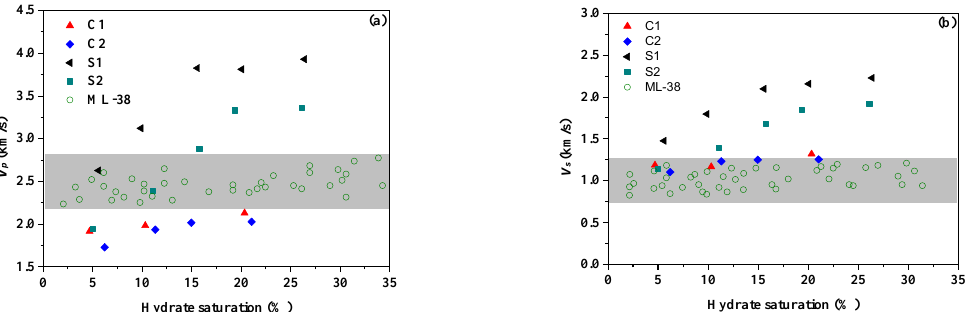
Figure 5. The P-wave velocity (a) and S-wave velocity (b) versus hydrate saturation at the effective confining pressure of 3 MPa, respectively. Clayey hydrate-bearing specimens (C1, C2), sandy hydrate-bearing specimens (S1, S2), and the field data of Mallik 2L-38 well in Northern Canada (circles and grey shading).